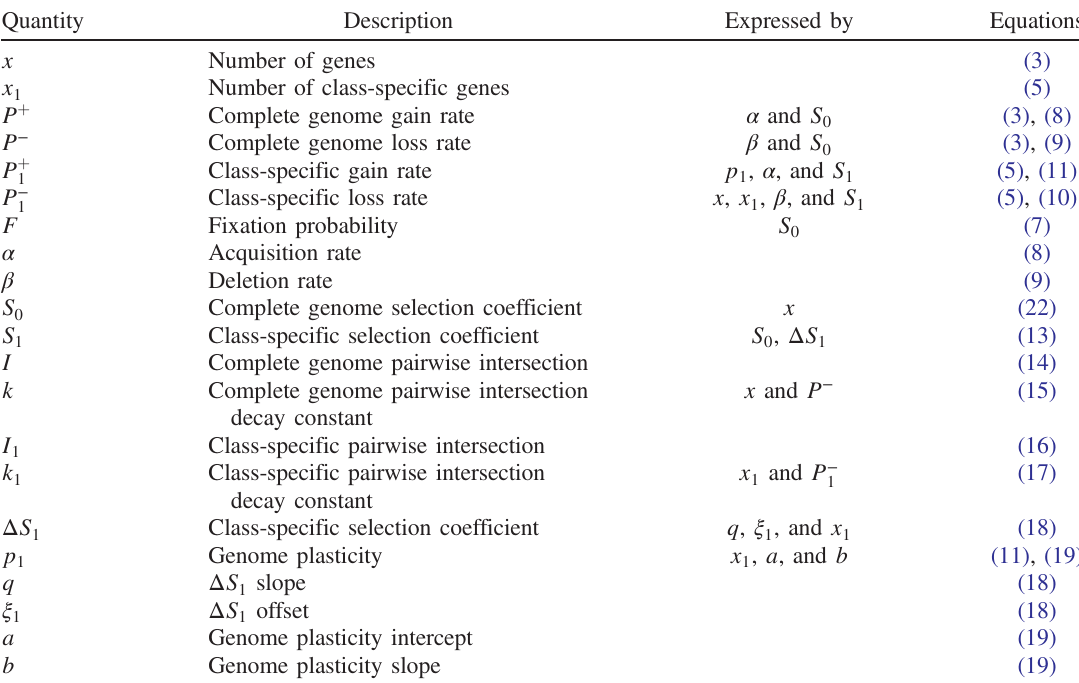
TABLE II. Model variables and parameters.